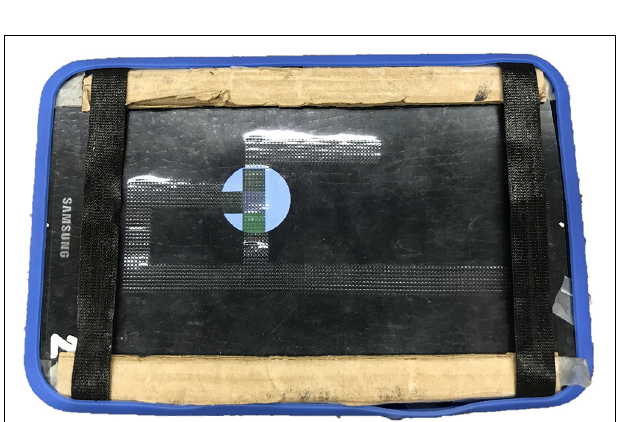
FIGURE 4 | Photograph of the Hybrid Interactive Map (HIM) tactile overlay as used by